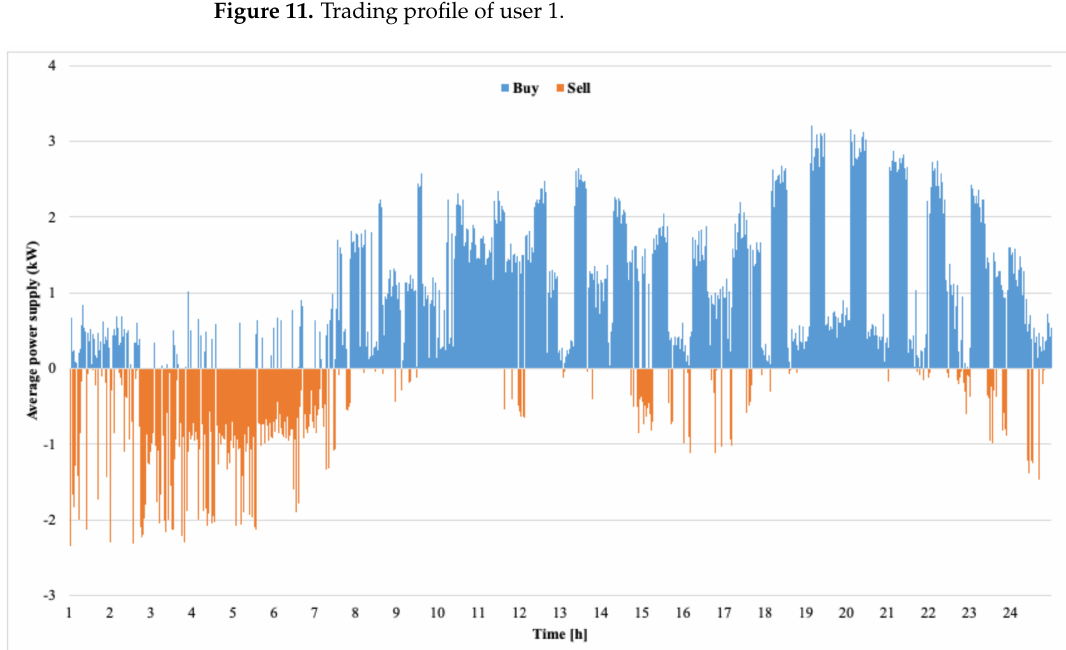
Figure 12. Trading profile of user